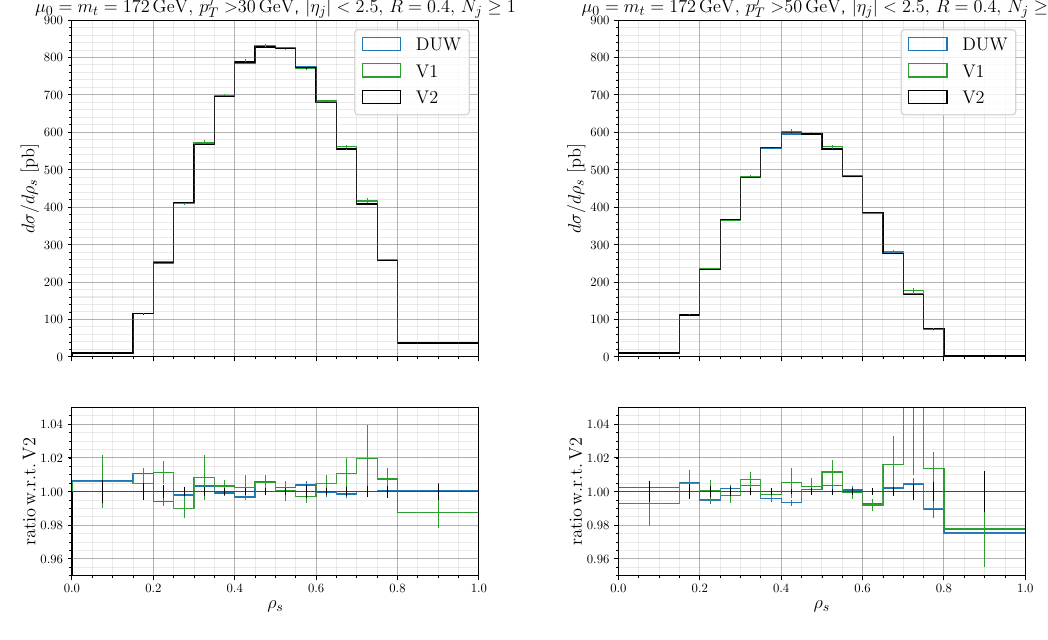
Figure 1 . Comparison of predictions of the ρ s distribution for t ¯ tj + X production in pp collisions √ at S = 13 TeV using different frameworks described in the text: Powheg-Box-v2 (black) vs. Powheg-Box-v1 (green) vs. the in-house NLO implementation of Dittmaier-Uwer-Weinzierl (blue) in an analysis setup where at least one light jet reconstructed with the anti- k T algorithm with R = 0 . 4 is required, with | η j | < 2 . 5 and a p j -cut of at least 30 GeV (left panel) and 50 GeV (right T panel). The renormalization and factorization scales are fixed to the value of the top-quark mass m t = 172